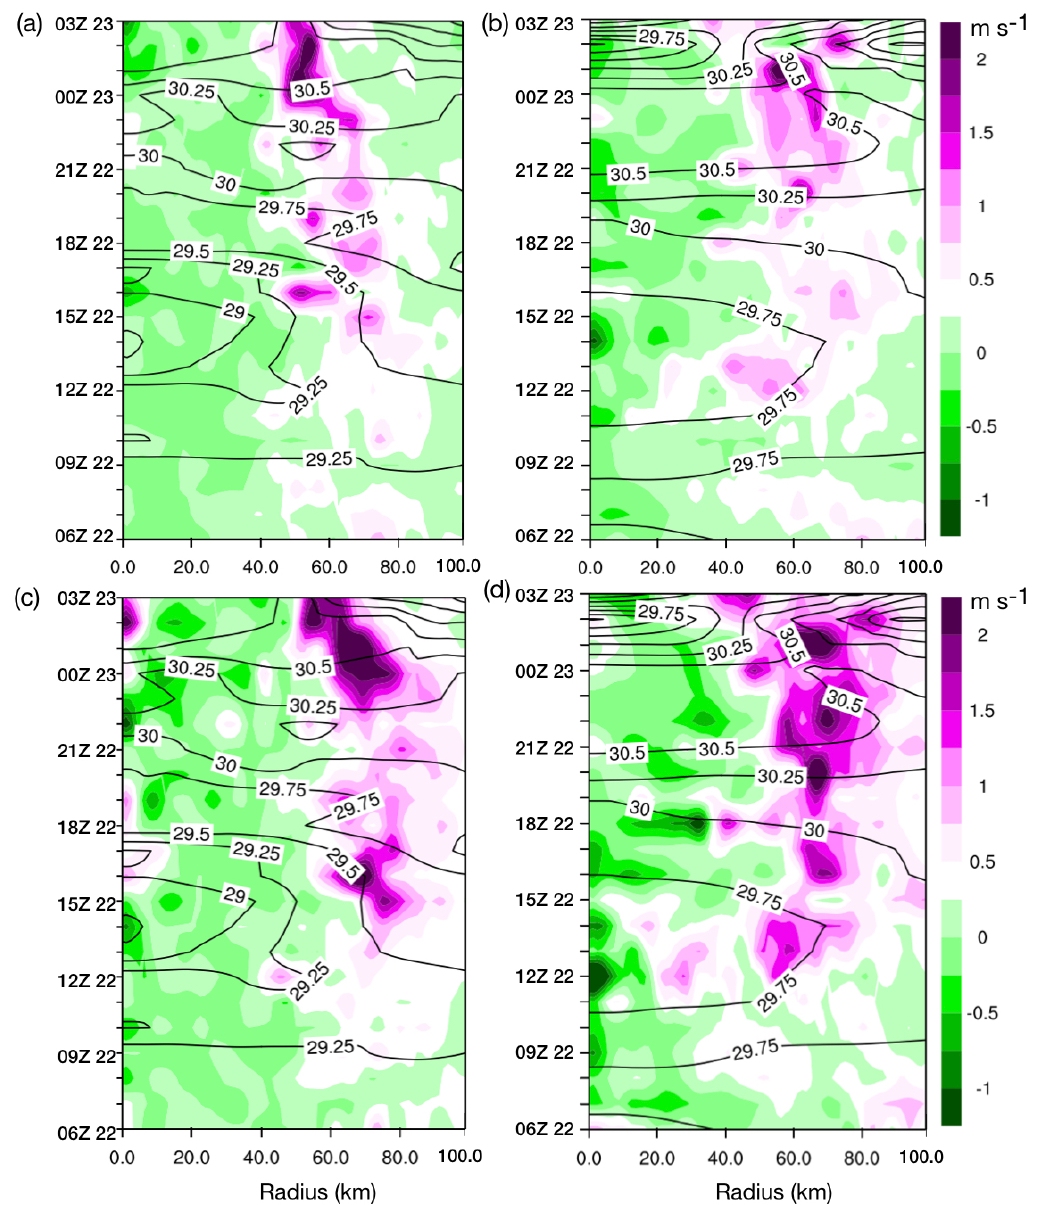
Figure 10. Radial-time cross section of the azimuthally averaged vertical velocity (shade, m s − 1 ) at 6.5 km and 12.0 km altitude. ( a ) CPL and ( b ) FO experiments at 6.5 km altitude; ( c ) CPL and ( d ) FO experiments 12.0 km altitude. Contours denote azimuthally mean SST ( ◦ C) distributions in both experiments. Ordinate values are time from 0600 UTC on 22 August to 0300 UTC 23